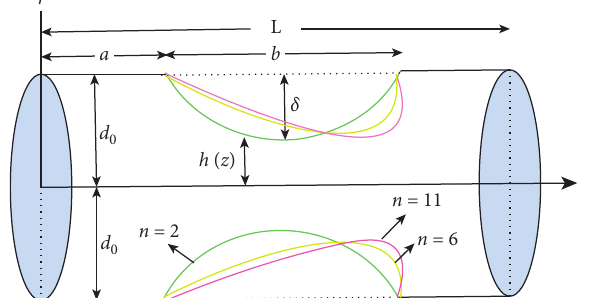
Figure 1: Diagram of axially nonsymmetric stenosis in the